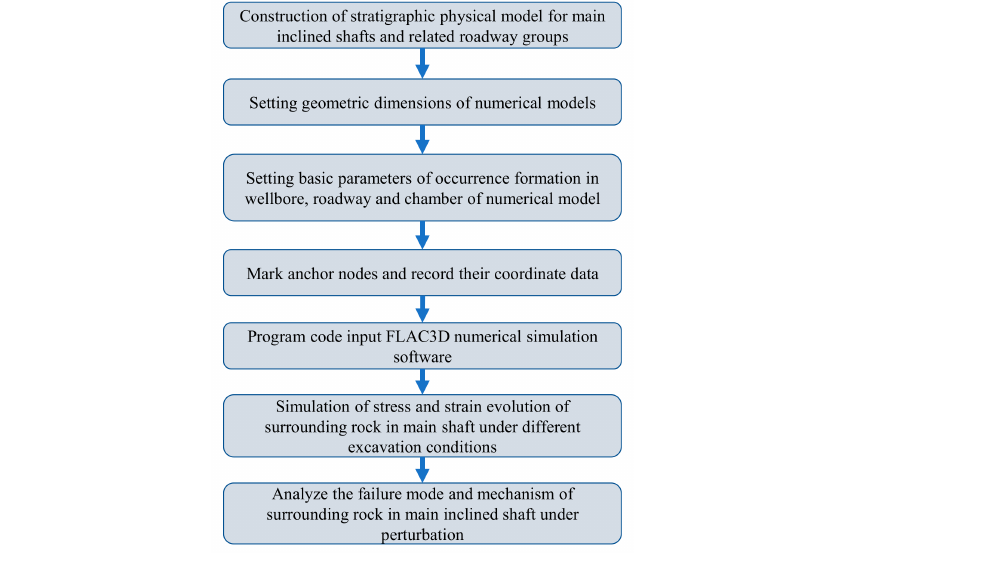
Figure 3. Flow chart illustrating the steps of the numerical analysis.